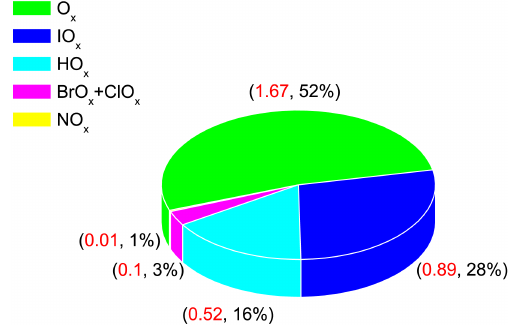
Figure 6. Calculated present-day ozone loss rates by the different chemical families in the MBL (Brasseur and Solomon, 2005). The first number in each set of parentheses (in red) provides the O 3 loss rate by the colour-coded family (in nmolmol − 1 d − 1 ). The second value in each set of parentheses provides the relative contribution of each depleting family to the total ozone chemical